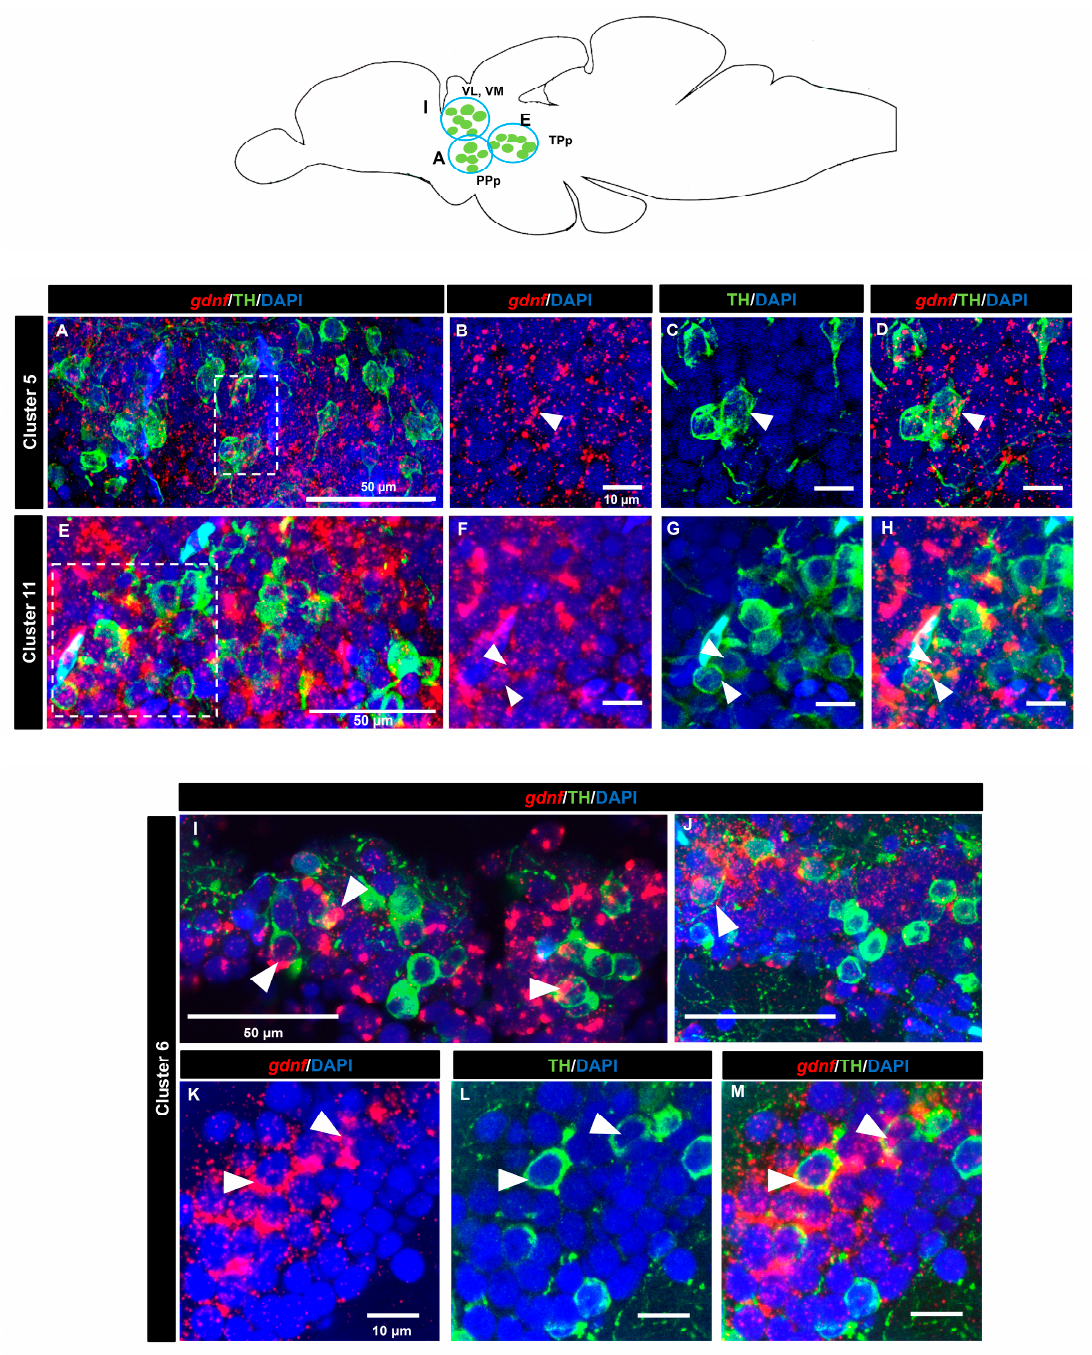
Figure 8. Co-expression of gdnf mRNA with catecholaminergic subpopulations in the diencephalon. FISH / immunohistochemistry for gdnf (red) and TH (green) on sagittal sections of ( A – D ) cluster 5 in parvocellular preoptic nucleus, posterior part (PPp), ( E – H ) cluster 11 in periventricular nucleus of posterior tuberculum (TPp), and ( I – M ) cluster 6 in anterior, intermediate, ventrolateral, andventromedialthalaminuclei(A,I,VL,andVM).Bluecirclesintheschematicsagittalviewoftheadult zebrafish brain represent the regions of the respective TH neuron subpopulations. White dashes outline the respective magnified regions that are constructed from selected z-stacks. The white arrowheads indicate the co-localization of gdnf and